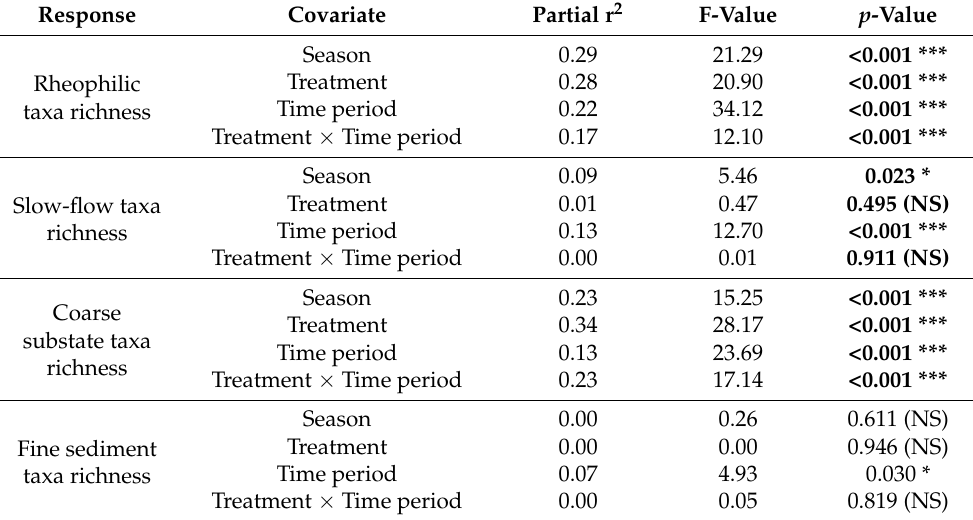
Table 5. Macroinvertebrate α -diversity responses to river restoration indicated by linear model outputs. Significant models are indicated in bold, and stars denote the degree of significance: * p ≤ 0.05; *** p ≤ 0.001; NS, non-significant.